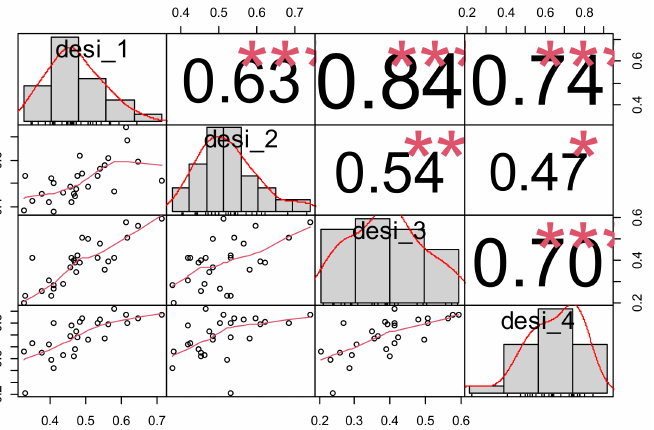
Figure 5. Pearson correlation coefficients, distribution and correlations of variables, 2016. (*** signifi- cance level p < 0.001, ** significance level p < 0.01).